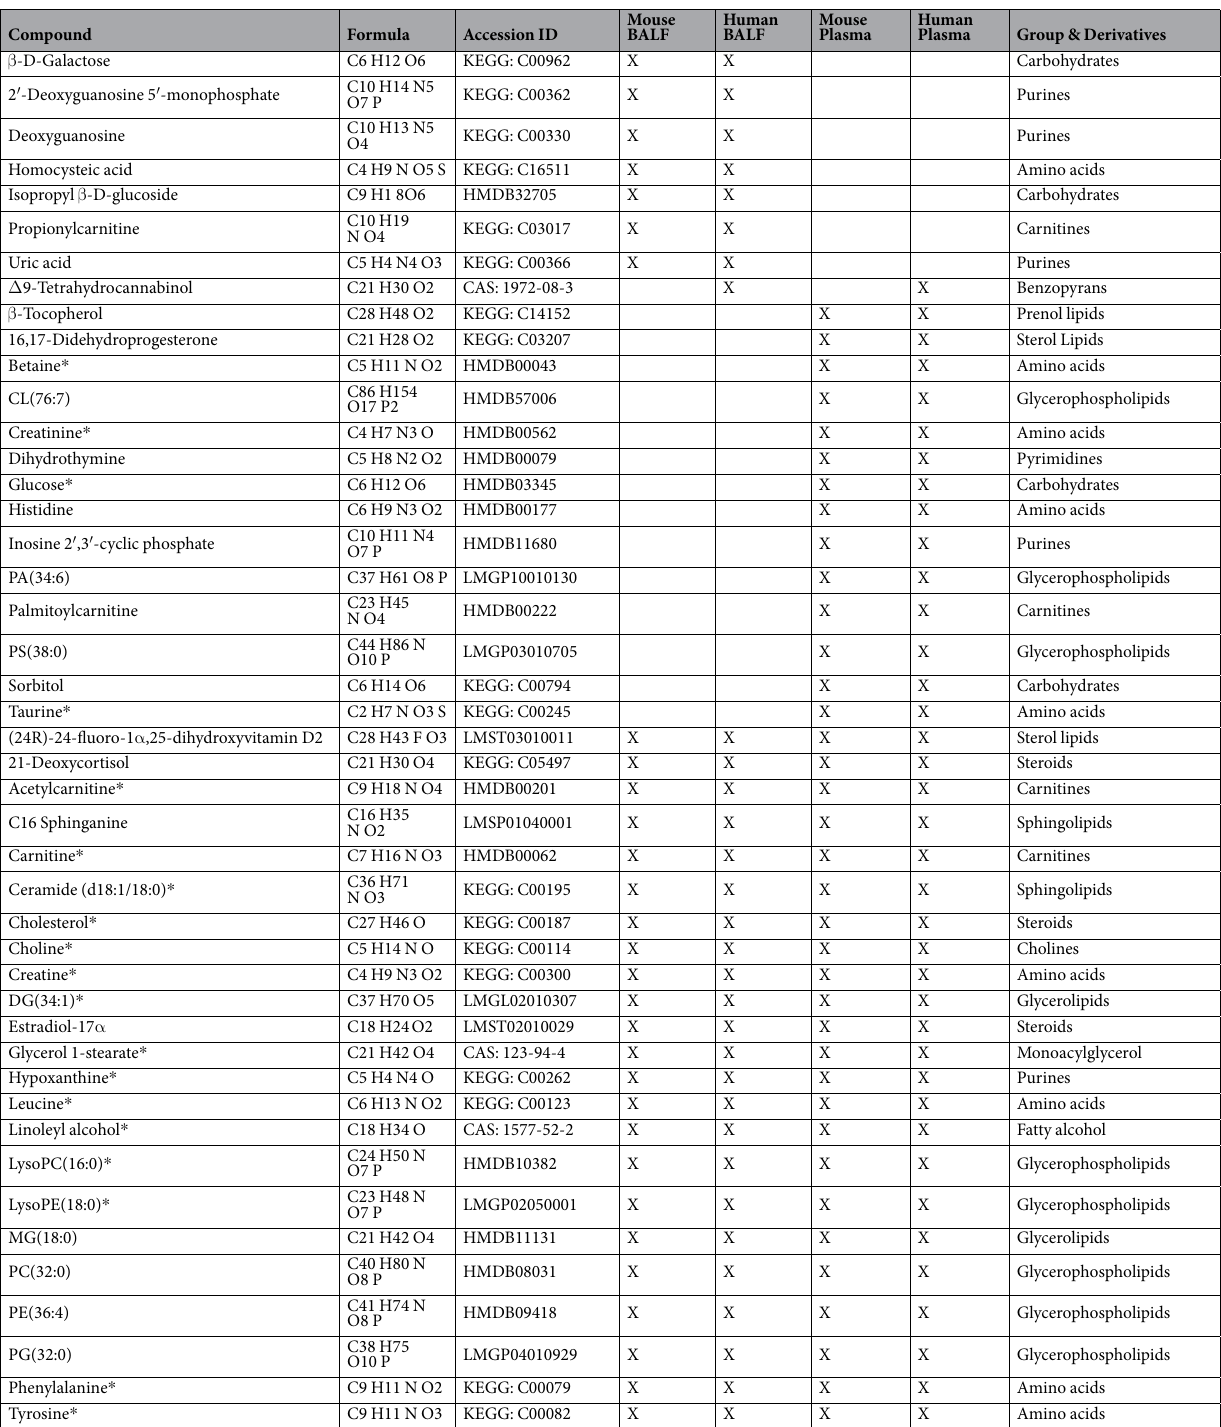
Table 1. Representative overlapping metabolites in human and mouse BALF and/or human and